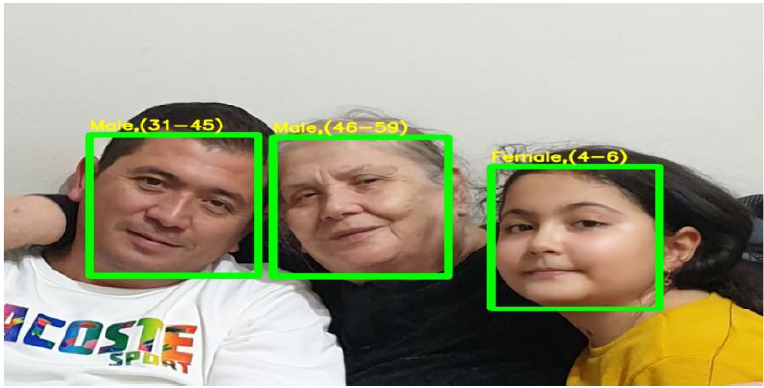
Fig. 10. Age and gender classification of a middle aged man, an elderly, and a child.